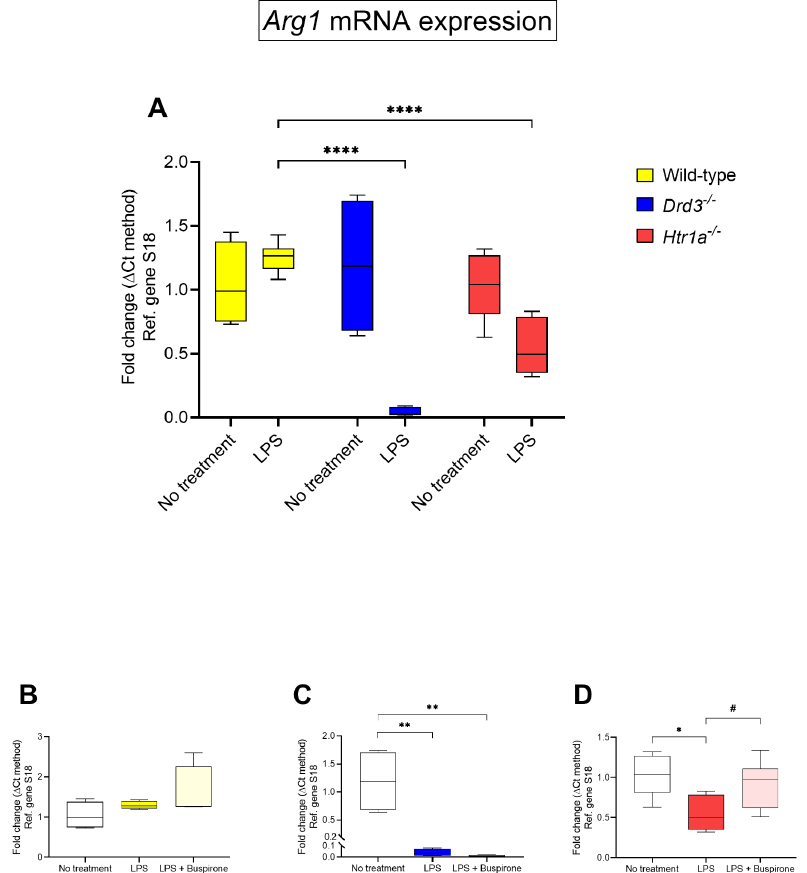
Figure 7. Arg1 mRNA expression following exposure to LPS and treatment with buspirone for 24 h. Gene expression was measured using real- time qPCR and quantified using the ΔΔCt method after normalization to the S18 housekeeping gene. ( A ) Box and whisker plots showing the differential expression of Arg1 transcripts in untreated or LPS-treated wild type, Drd3 −/− and Htr1a −/− cells or after co-treatment of ( B ) wild type, ( C ) Drd3 −/− and ( D ) Htr1a −/− cells with LPS in combination with buspirone. Results are presented as mean fold changes with respect to no treatment ± SEM. Baseline levels of no treatment groups were set to 1. * p < 0.05, ** p < 0.01 or **** p < 0.0001 vs. no treatment or # p < 0.05 vs. LPS, as determined by one-way or two- way ANOVA followed by Tukey or Dunnett’s post-hoc tests.